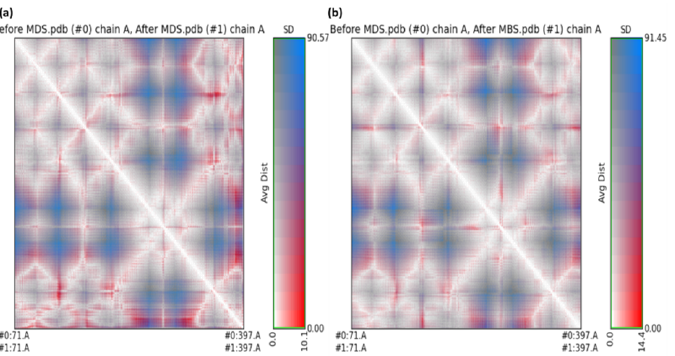
Figure 12. The RR distance map displaying patterns of spatial interactions between ( a ) the unbound serotonin receptor and the serotonin receptor after the simulation for GpnS ; and ( b ) the unbound serotonin receptor and serotonin receptor after simulation for CuGS , showing the average distance and standard deviation for all amino acid pairs. (MDS = Molecular Dynamics simulation). The zero distance between two residues is shown by the white diagonal on the map, whereas the red and blue components reflect residue pairs with the highest distance dif- ferences in the two conformations. The average radius of gyration (Rg) value of 25.75 and 26.75 Å was observed for GpnS and CuGS , respectively. It can be seen that over the sim- ulation time, the Rg for CuGS decreased, indicating that the structures became more com- pact (Figure 13). Figure 13. The radius of gyration (Rg) for the unbound serotonin receptor (yellow), GpnS complex (black), and CuGS complex (brown) during the 100 ns simulation time. The grid search at 25 × 11 × 14 = grid and rcut = 0.35 revealed the H-bond between the receptor and ligand ( GpnS and CuGS) , plotted against time (Figure 14). On calculat- ing the hydrogen bonds between the ligand (Gpn and [Cu(II)–(Gpn)]) and protein (3706 atoms), 508 donors and 987 acceptors were observed. The number of H-bonds per time frame on average were found to be 2.107 and 1.104 out of a possible 250,698 for CuGS and GpnS , respectively. Overall, it was discovered that the protein–receptor interaction in- creased the number of hydrogen bonds substantially, which was more in CuGS . Figure 15 shows that the SASA (solvent accessibility surface area) values changed due to the binding of the ligand (Gpn and [Cu(II)–(Gpn)]) to the receptor (serotonin). The decreased SASA value indicates the reduced pocket size and alteration in the protein structure con- formation with increased hydrophobicity.